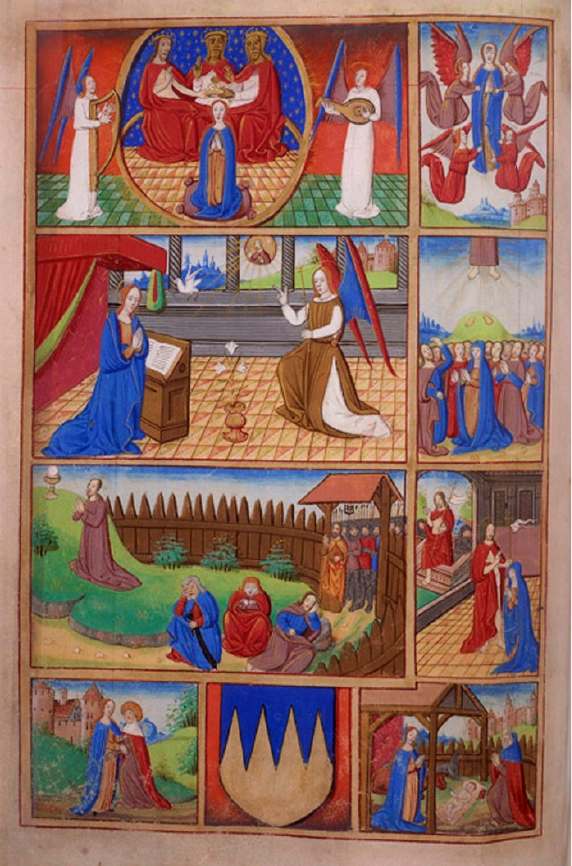
Figure 11. Opening pictorial cycle, the Hours of Thomas Butler, f.15v, © British Library Board.